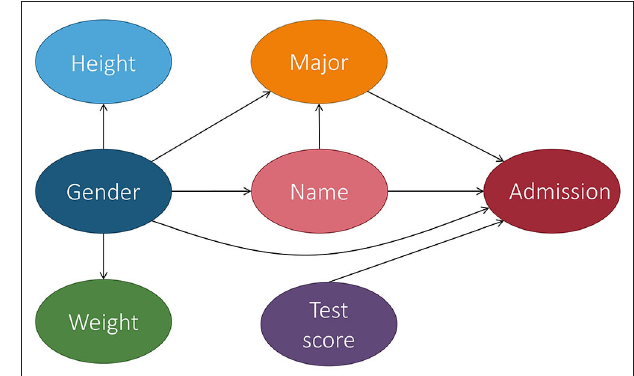
FIGURE 5 | Extension of Figure 4 in which we add a proxy variable: name. Name is significantly correlated with the marginalization attribute gender since a person’s name is often chosen based on their